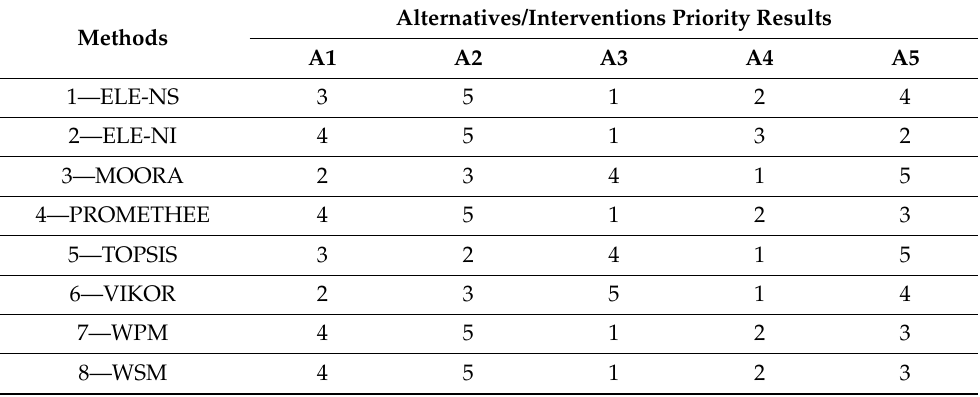
Table 6. Rank calculated using MCDMs with L nN method for normalization.